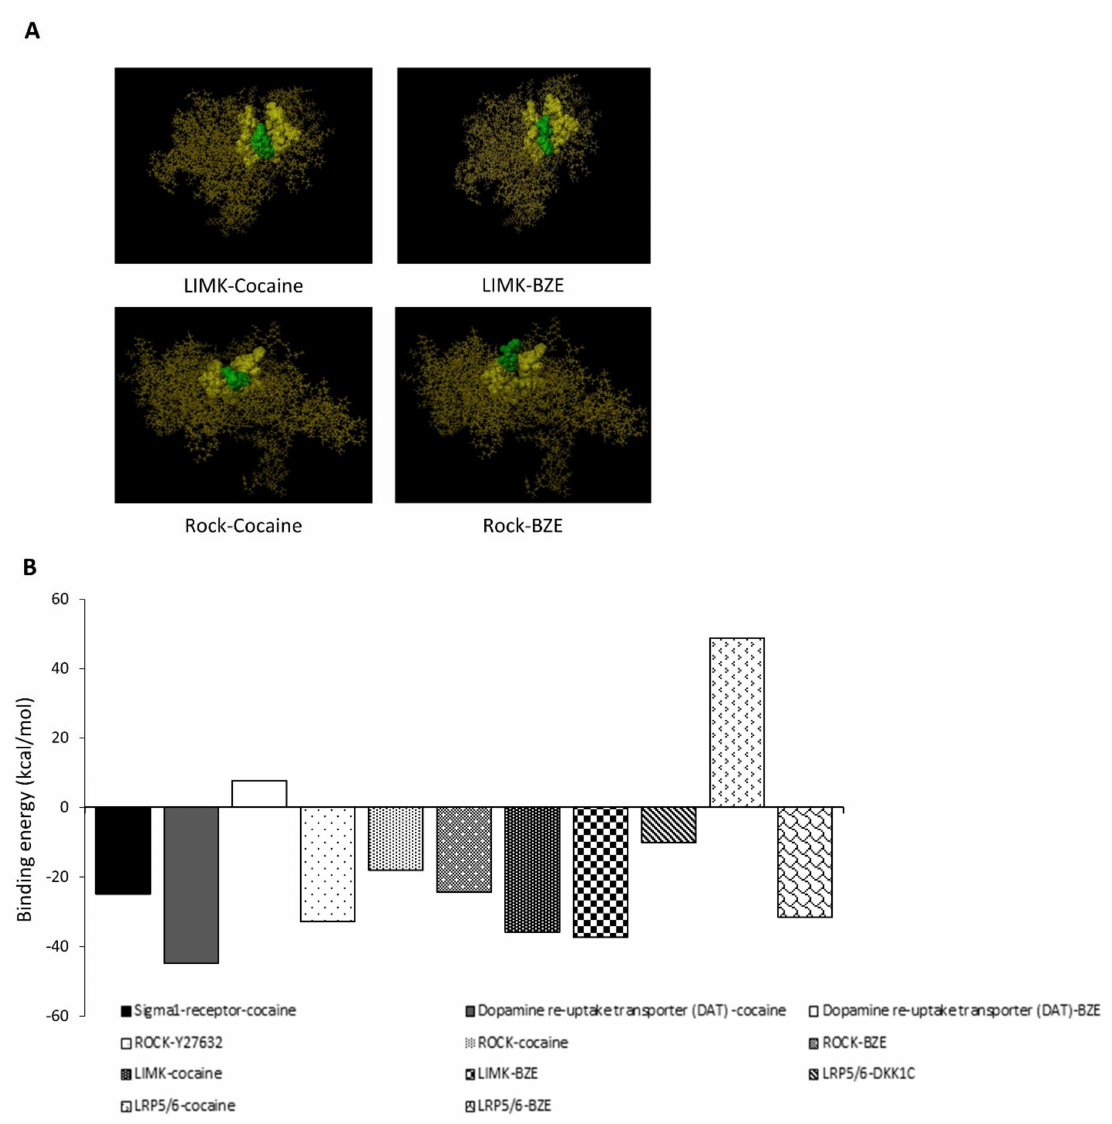
Figure 5. In-silico studies of cocaine and its metabolite BZE modelled against key signalling regulators. ( A ) Schematic of LIM-kinase modelled against cocaine and BZE at the ATP binding site, both ligands indicate similar active site occupancy with BZE representing a greater molecular fit for the specified site of interaction. Yellow and green space filling views represent the LIMK ATP binding pocket and ligand (cocaine and BZE), respectively. Images generated from Scigress docking software. ( B ) Binding energies as measured in kcal/mol generated by in-silico studies of cocaine and its metabolite BZE modelled against key signalling regulators. Each model was generated using acknowledged crystallographic structures and subsequently programmed using the Scigress docking software for targeted interactions. These results suggest that both cocaine and BZE can act as ABP signal transduction mediators, with LIM K and ROCK with lower binding energies comparable to known cocaine receptors such as Sigma 1 and DAT. In relation to canonical Wnt signalling, the LRP5/6 receptor displays high binding energy requirement for cocaine but favourable conditions for